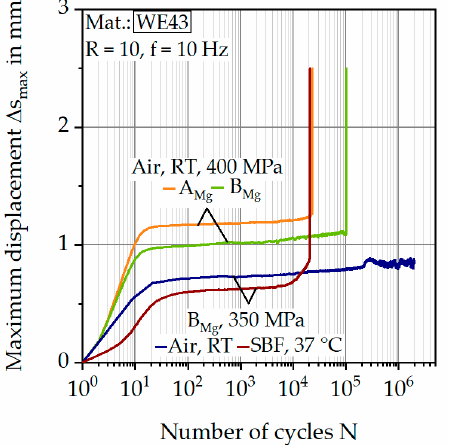
Figure 18. Δ s max -N curves for different batches and testing conditions.